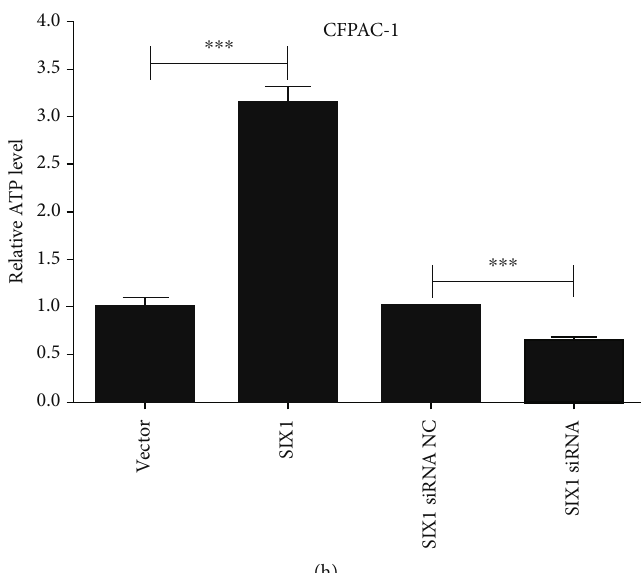
Figure 2: SIX1 promotes glycolysis in PC cells. (a, b) Relative expression of SIX1 by qRT-PCR and western blotting in PC cells with SIX1 overexpression vector and siRNA; β -actin served as the internal control. (c – h) Glucose consumption, lactate production, and ATP levels were measured in SIX1-overexpressing and SIX1 knockdown PC cells. The data are presented as the mean ± SD from three independent experiments. ∗ P ≤ 0 : 05 , ∗∗ P ≤ 0 : 01 , and ∗∗∗ P ≤ 0 : 001